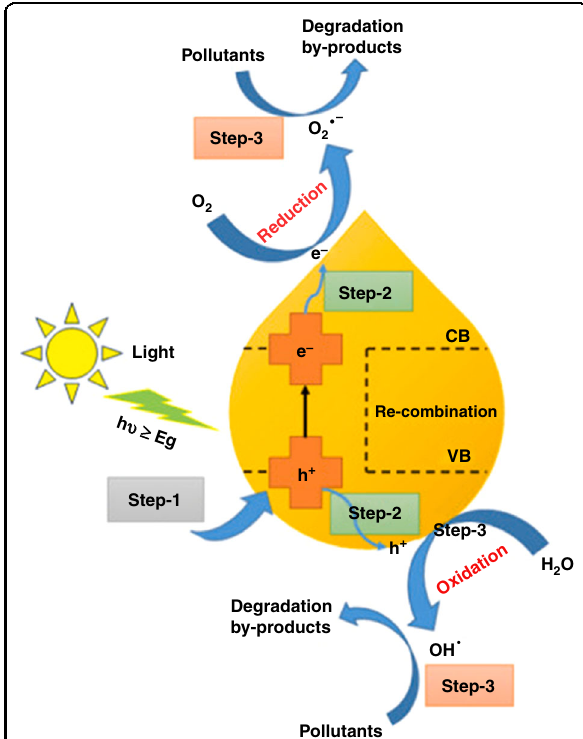
Fig. 15 Mechanistic illustration of photocatalytic degradation involved in the degradation of organic molecules 178 .